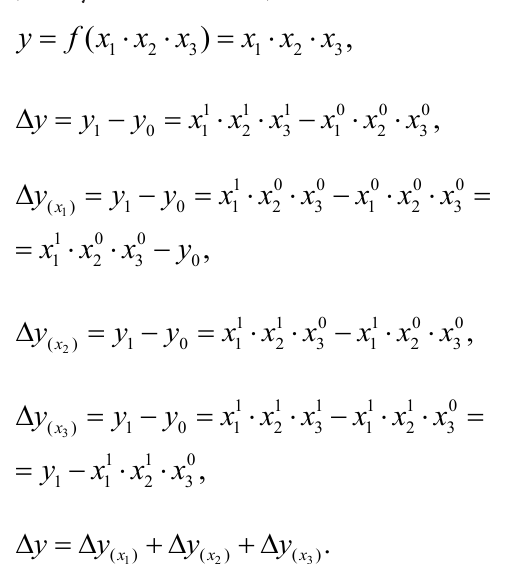
Algorithm of the method of chain